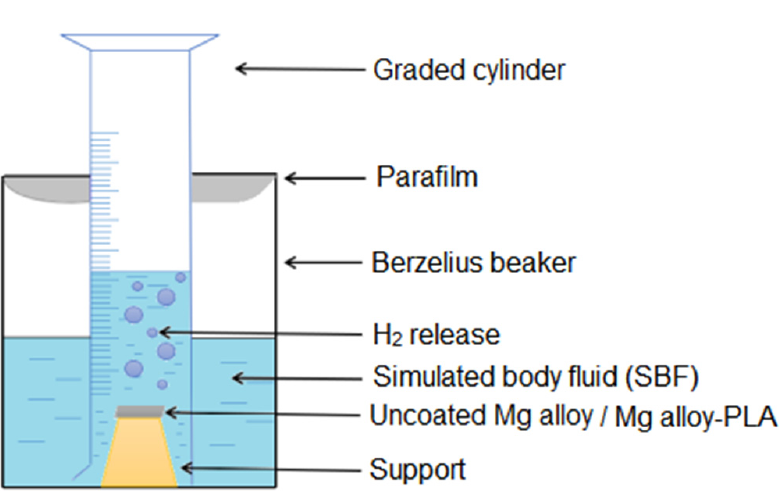
Scheme 1. Schematic illustration for volume measurement of H 2 evolution.